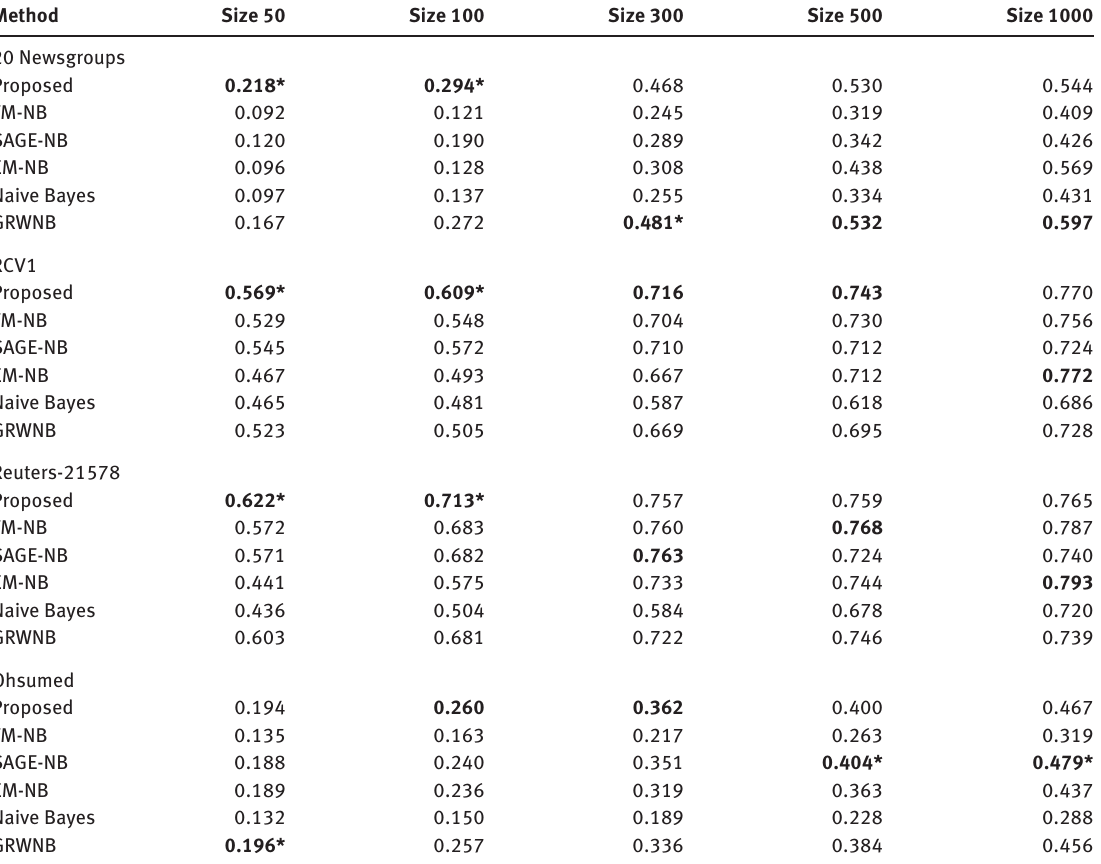
Table 2: (Macro-averaged) Break-even Point for the Proposed Method and Previous Methods using Three Different Corpora Trained with 50, 100, 300, 400, and 1000 Training Documents. Bold Font Marks Highest Break-even Point. Asterisk Marks Statistical Significance using Pairwise Comparison.